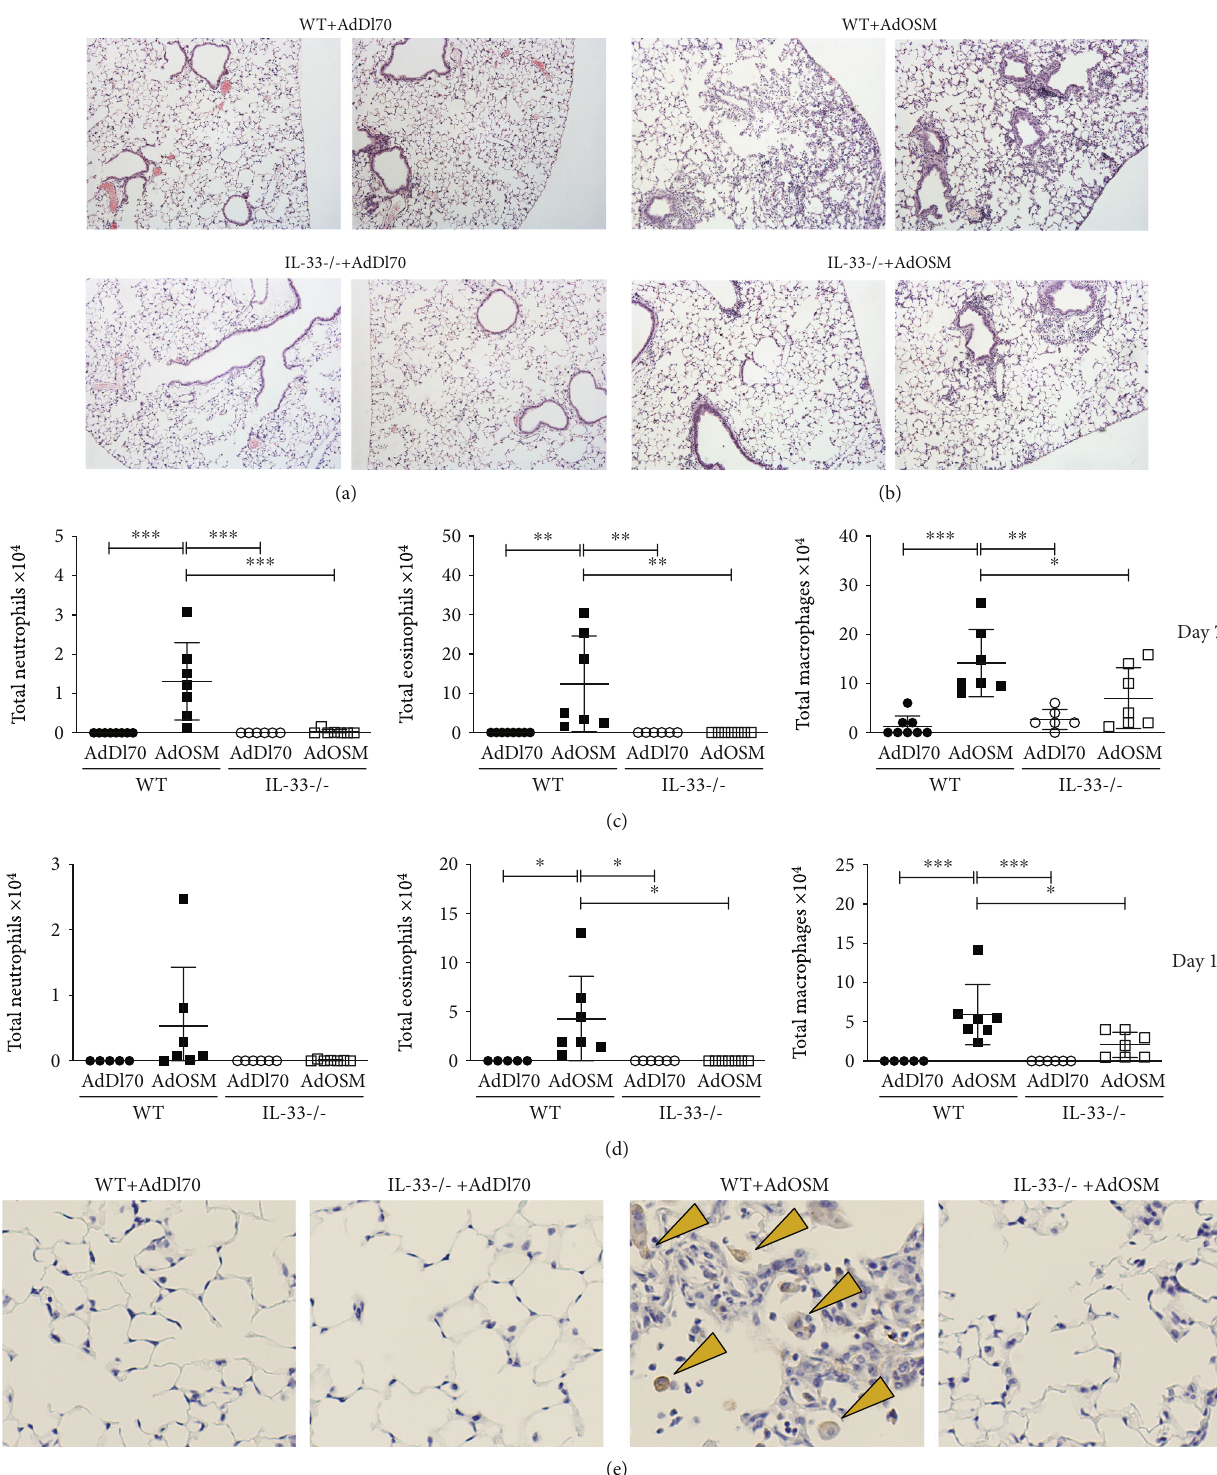
Figure 3: IL-33 is required for AdOSM-mediated lung in fl ammation. C57Bl/6 mice were endotracheally administered AdDl70 (control) or AdOSM and analyzed after 7 or 14 days. Representative H&E lung sections are shown from two di ff erent mice. (a) Wild-type (WT; top) or IL- 33-/- (bottom) mice infected with AdDl70. (b) Wild-type (WT; top) or IL-33-/- (bottom) mice infected with AdOSM. (c) Total cells collected from bronchoalveolar lavage (BAL) fl uid from C57Bl/6 mice at Day 7 (c) or Day 14 (d). Hema-3 staining of cytospin slides of BAL cells was done to distinguish neutrophils, eosinophil, and macrophage cell populations. ∗ p < : 5 , ∗∗ p < : 01 , ∗∗∗ p < : 001 . N = 5 ‐ 7/group . (e) Representative images of arginase-1 (Arg1) immunohistochemistry staining (brown arrows) of lung sections from C57Bl/6 wild-type and IL-33-/- mice treated as described in